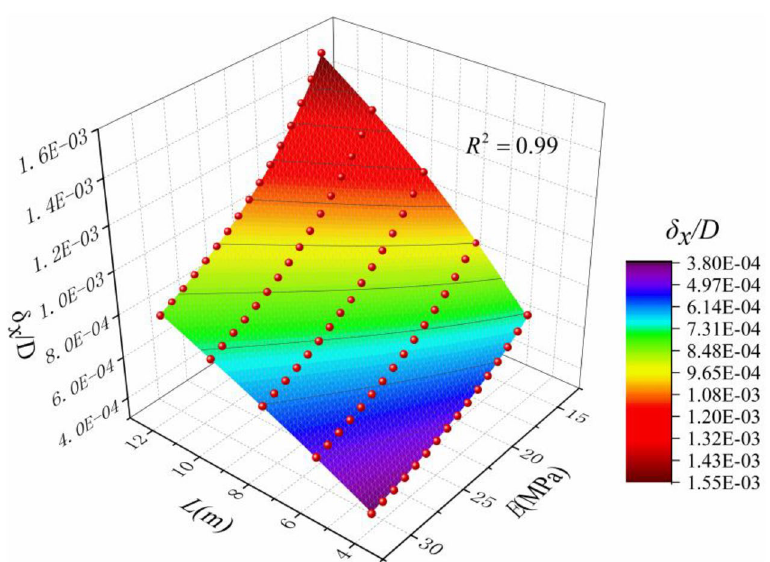
Figure 15. Maximum horizontal displacement based on impact of E , D , and L.